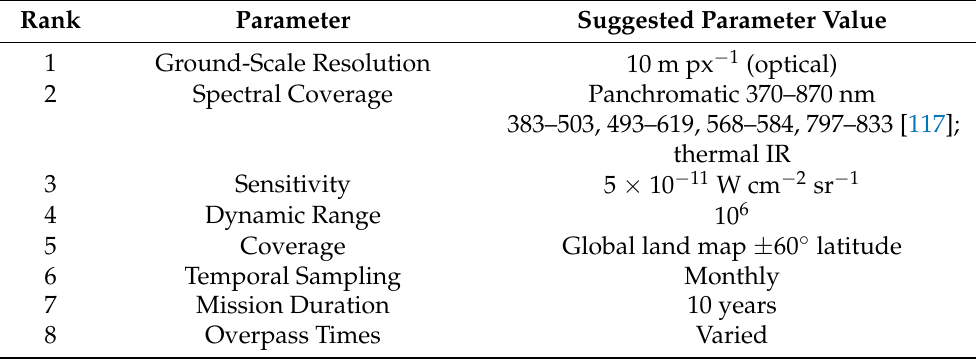
Table 2. Parameters ranked by importance for the proposed NITESat